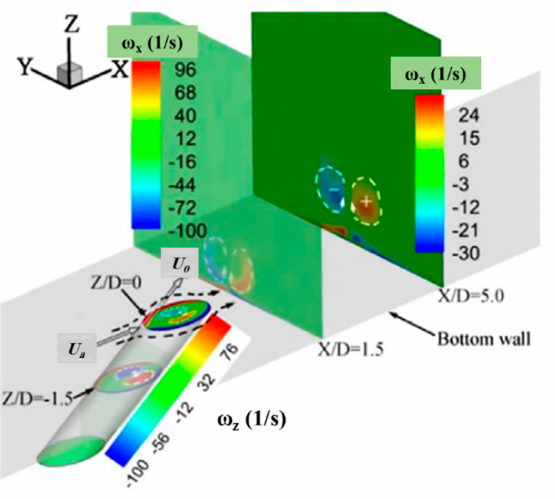
Figure 25. Time–averaged vorticity contours within the jet nozzle and the vertical planes